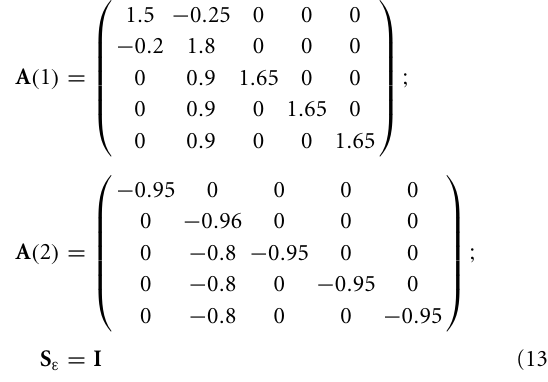
where (X, Y, Z) denotes the MNI coordinates in millimeters, and BA denotes Brodmann